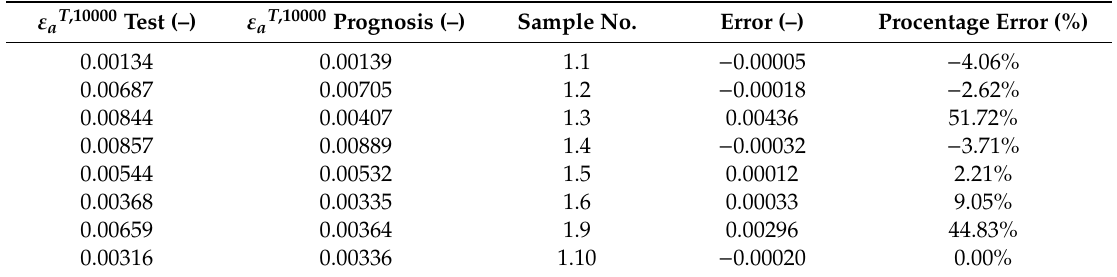
Table 3. Ex–post analysis of the 10,000th cycle: error and percentage error calculation results. ε aT ,10000 Test (–) ε aT ,10000 Prognosis (–) Sample No. Error (–) Procentage Error (%) Materials 2019 , 12 , x FOR PEER 0.00134 0.00139 0.00687 0.00705